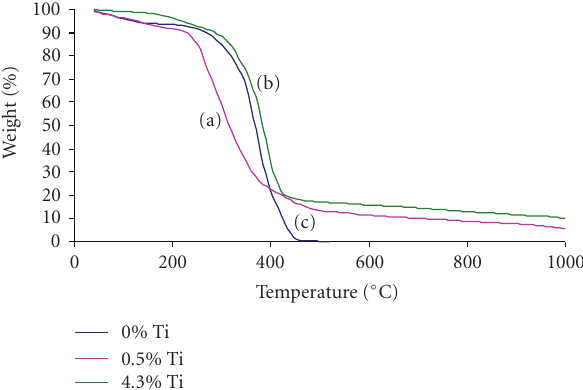
Figure 2: Thermogravimetric analysis of titanium containing nanocomposites and reference